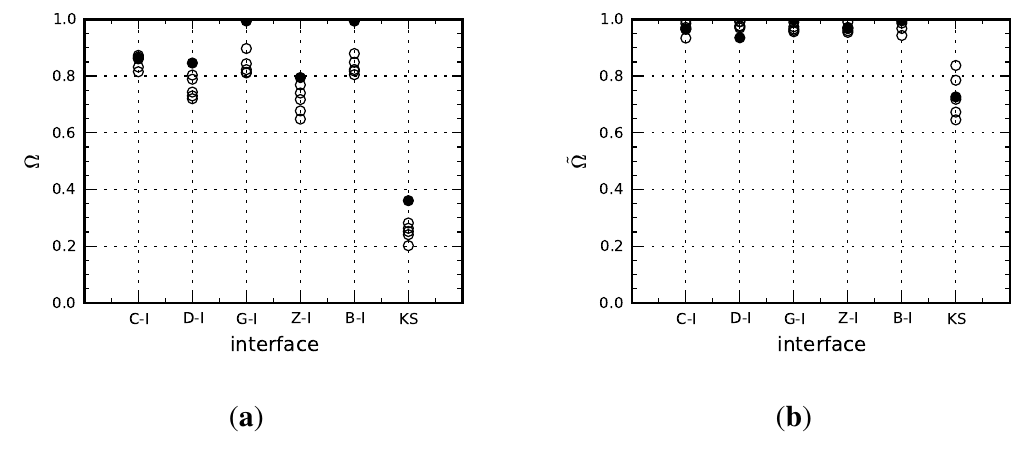
Figure 11. Plastic stability parameters plotted for each of the considered interfaces ( a ) total stability; and ( b ) instantaneous stability at 50% reduction. Filled circles are from the periodic bicrystal simulations and open circles are for the different multicrystal